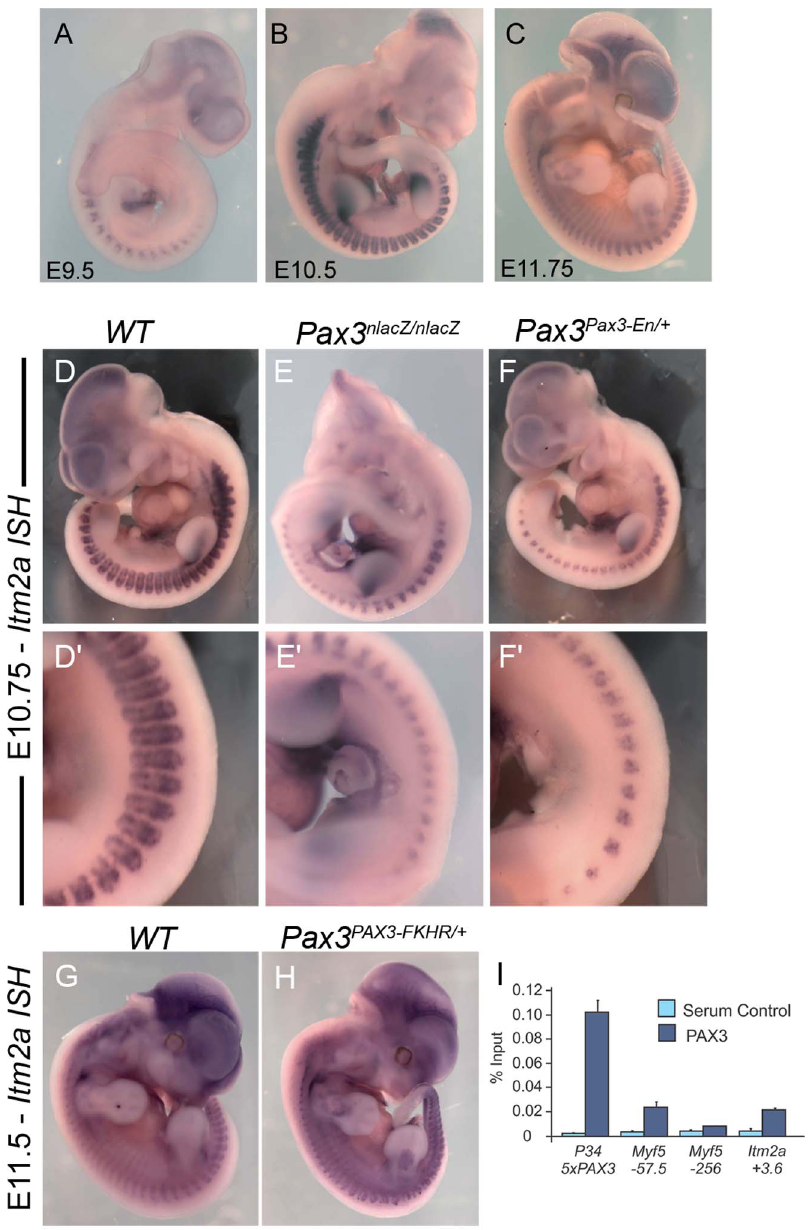
Figure 1. Itm2a is a novel Pax3 target. A–C, Whole mount in situ hybridization with an Itm2a antisense riboprobe at E9.5 (A), E10.5 (B) and E11.75 (C). D–F’, Whole mount in situ hybridization with an Itm2a antisense riboprobe on wild type (WT) (D, D’), Pax3 nLacZ/nLacZ (E, E’) and Pax3 Pax3-En/ + (F, F’) embryos at E10.5. D’–F’ show close-ups of the interlimb somite region. As expected, the modification of Itma transcription in the mutant is restricted to Pax3-expressing cells. G–H, Whole mount in situ hybridization with an Itm2a antisense riboprobe on wild type (WT) and Pax3 PAX3-FKHR/ + embryos at E11.5. I, Real-time quantitative PCR using primers for the putative Pax3 binding site identified in [19] in the Itm2a sequence at + 3.6 kb. The 5 Pax3- binding sites in the P34 transgene [21] and a functional Pax3 site at 2 57.5 kb from the Myf5 gene [11] provide positive controls. A Myf5 flanking sequence at 2 256 kb that does not bind Pax3 [11] provides a negative control. Results are expressed as a percentage of PCR signal on input DNA, showing enrichment after Pax3 immunoprecipitation, or with an IgG